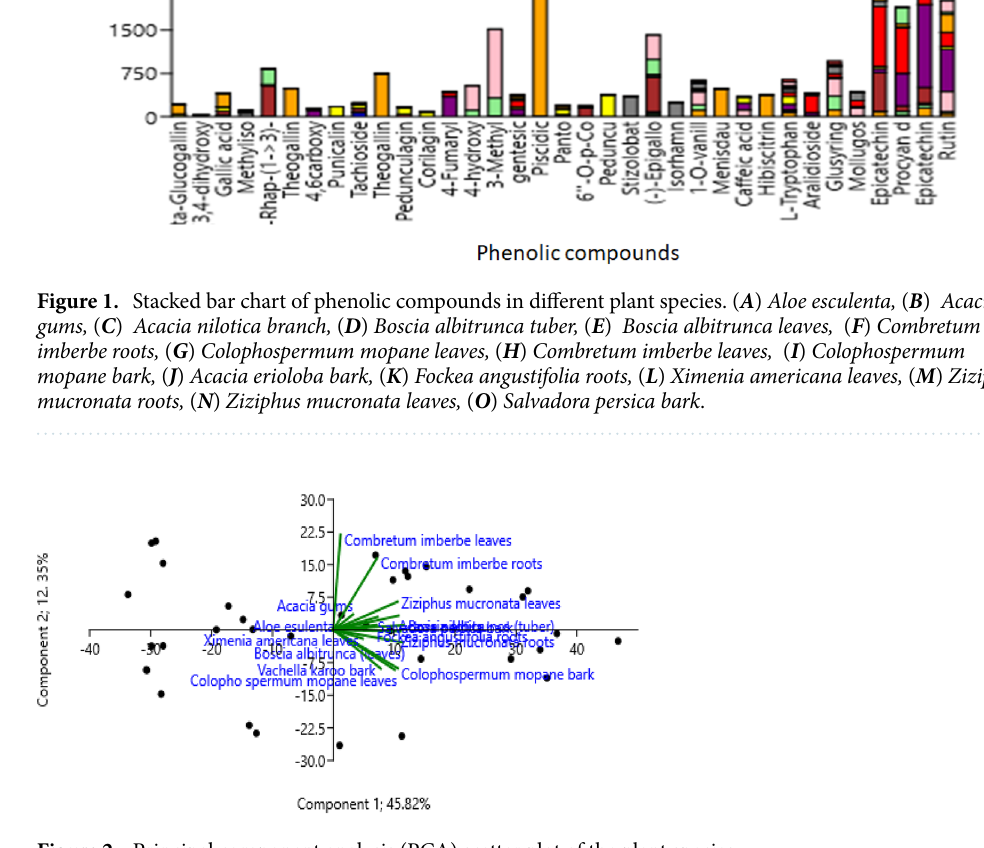
Figure 2. Principal component analysis (PCA) scatter plot of the plant